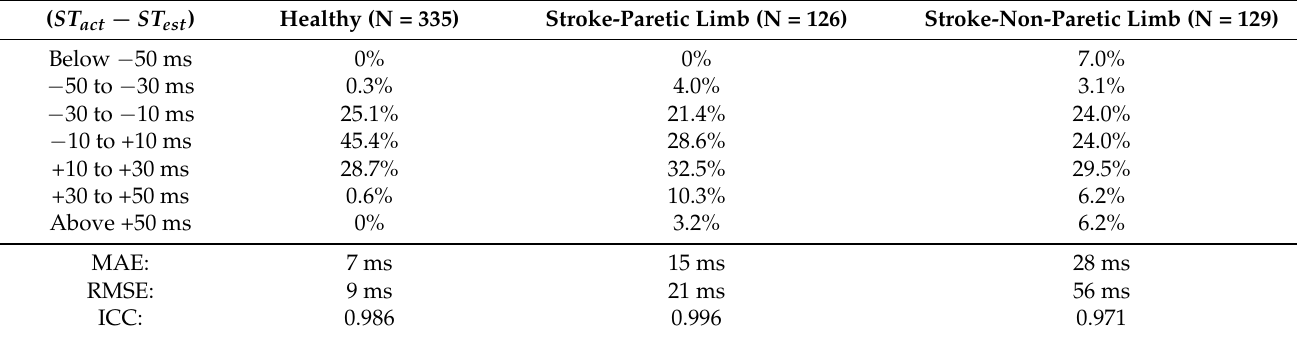
Table 2. Stride time measurement